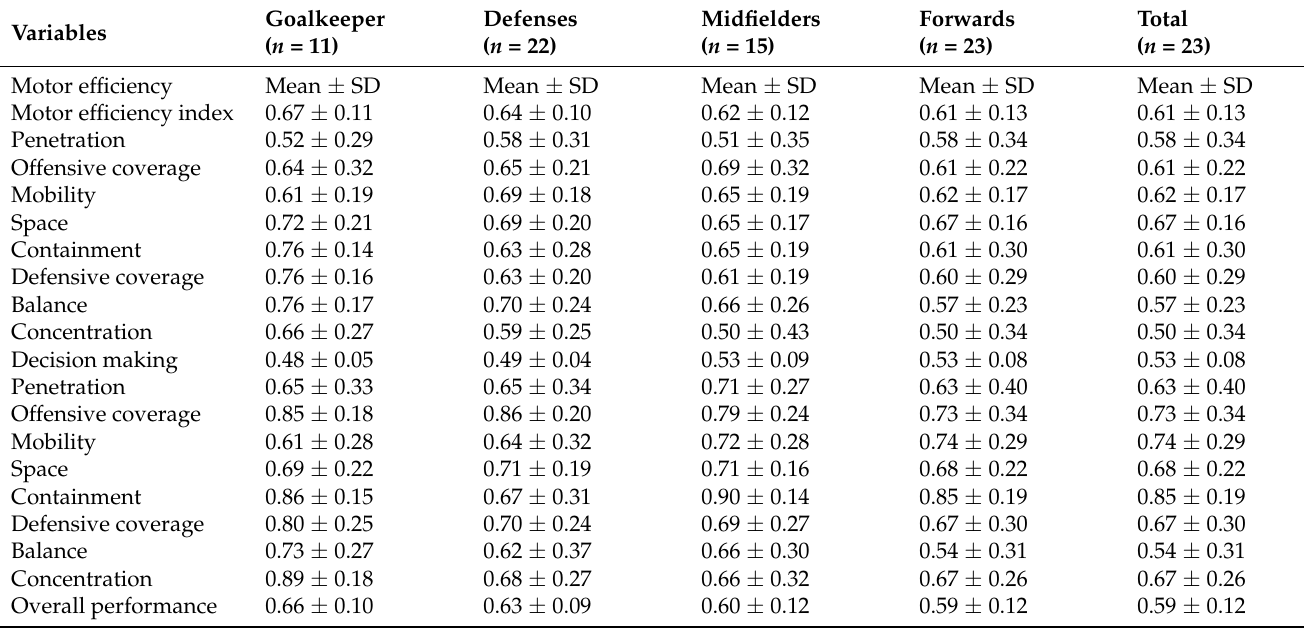
Table 6. Mean and standard deviation of motor effectiveness, decision making for each game’s principle, and overall performance by field positions.